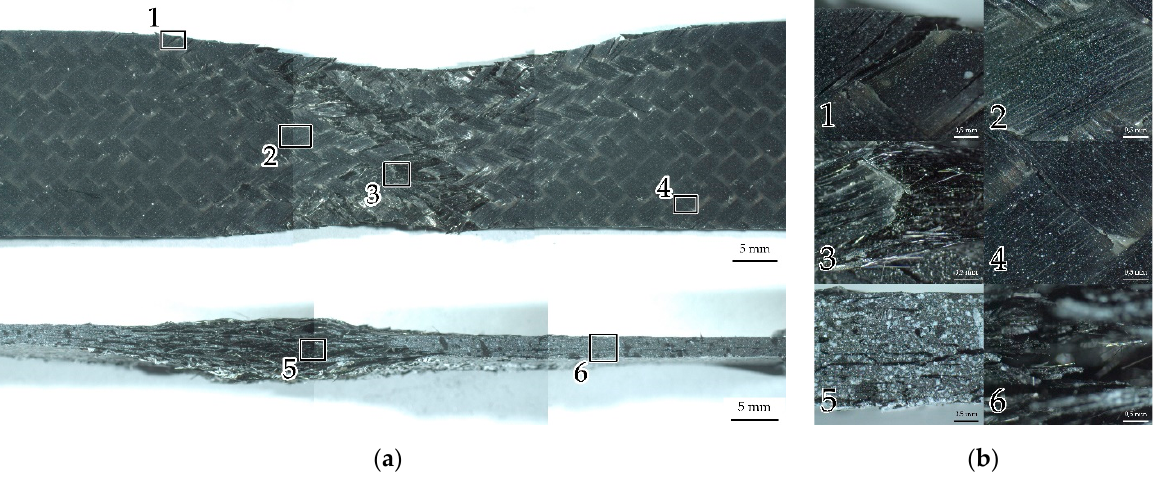
Figure 6. Sample after destruction: ( a ) Front and side surfaces close up; ( b ) magnified images of local areas. Numbers indicate typical damages: 1, 2—delamination between the tapes; 3, 4—breaks of fibers and tapes; 5—violation of adhesion between fibers and matrix inside the tape; 6—interlayer delamination.